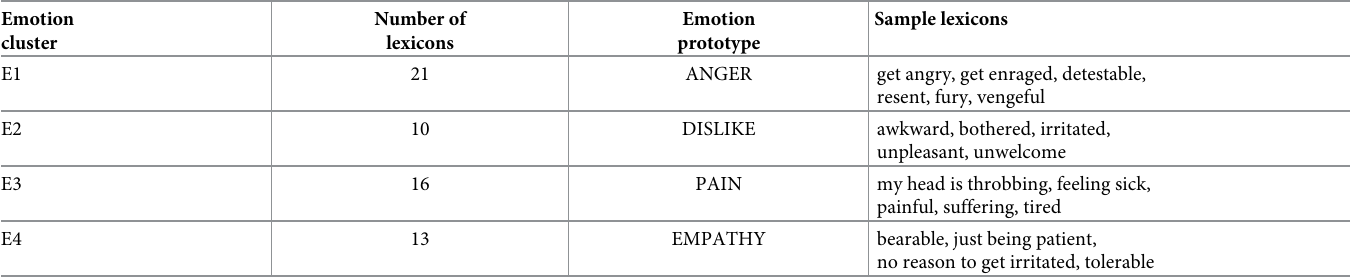
Table 4. Sixty lexicons grouped in four clusters. Emotion cluster